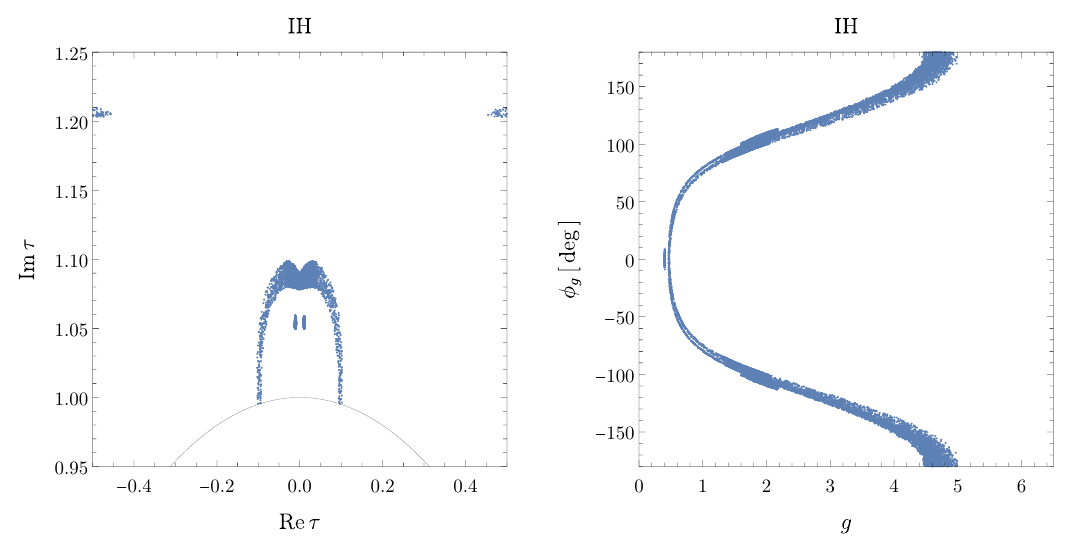
Figure 1 . Allowed region of τ (left) and ˆ g = ge iφ g (right) for inverted hierarchy. Each dot